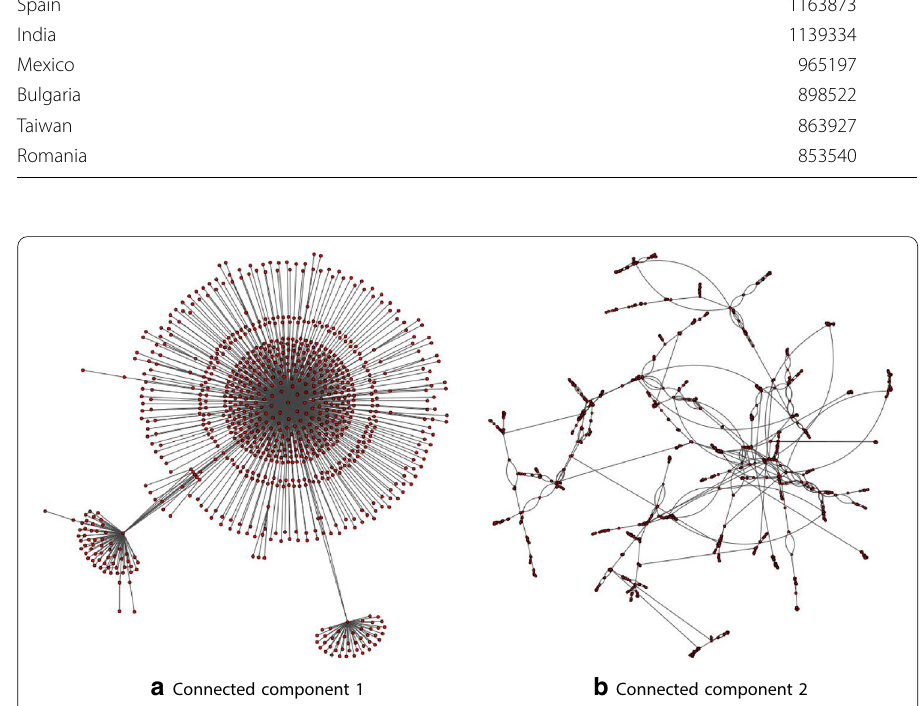
Fig. 3 2 examples of small